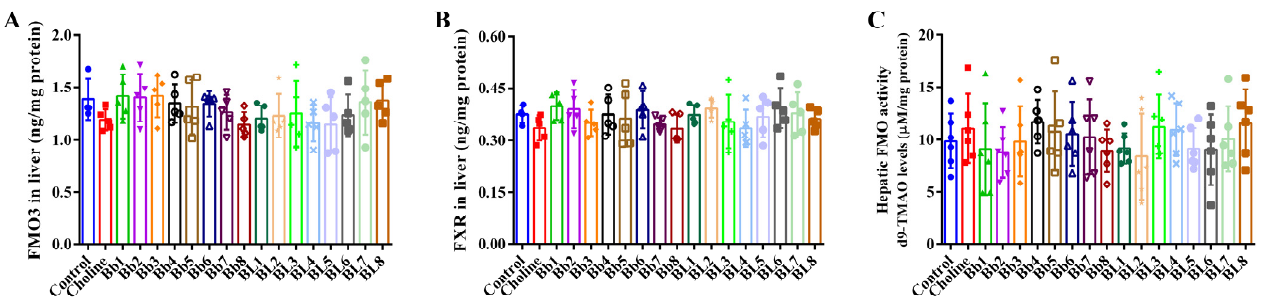
Figure 5. Bifidobacterium did not affect the expression levels of FMO3 and FXR and the enzyme activity of hepatic FMOs: ( A ) FMO3 in liver, ( B ) FXR in liver, ( C ) hepatic FMO activity. Values are mean ± SD, six mice per group.